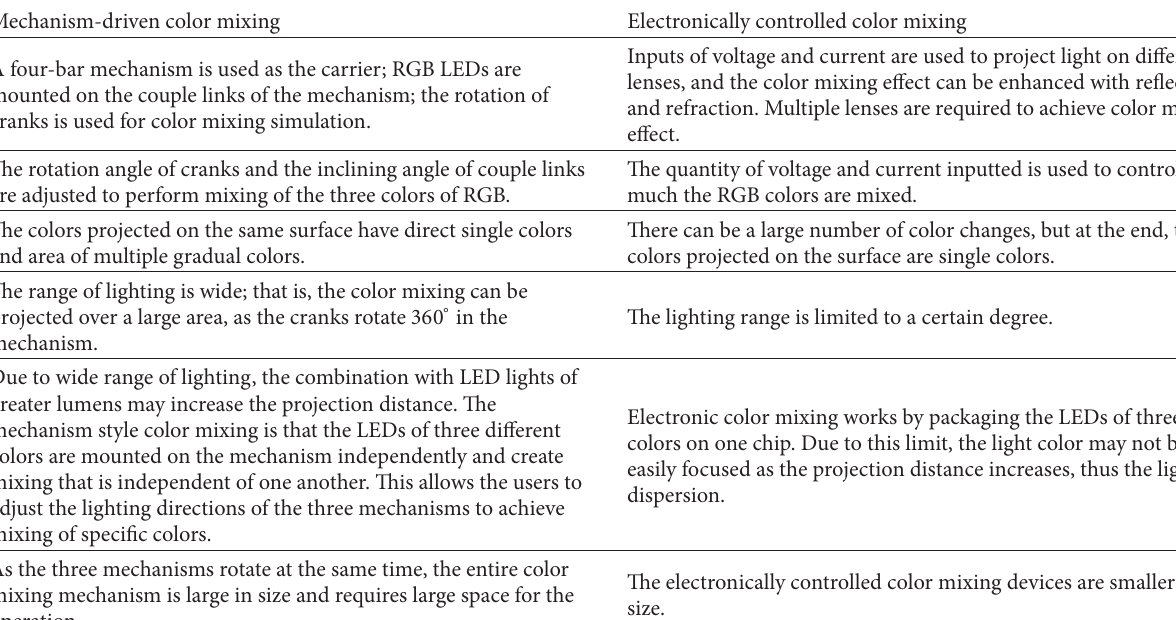
Table 1: Comparison of color mixing